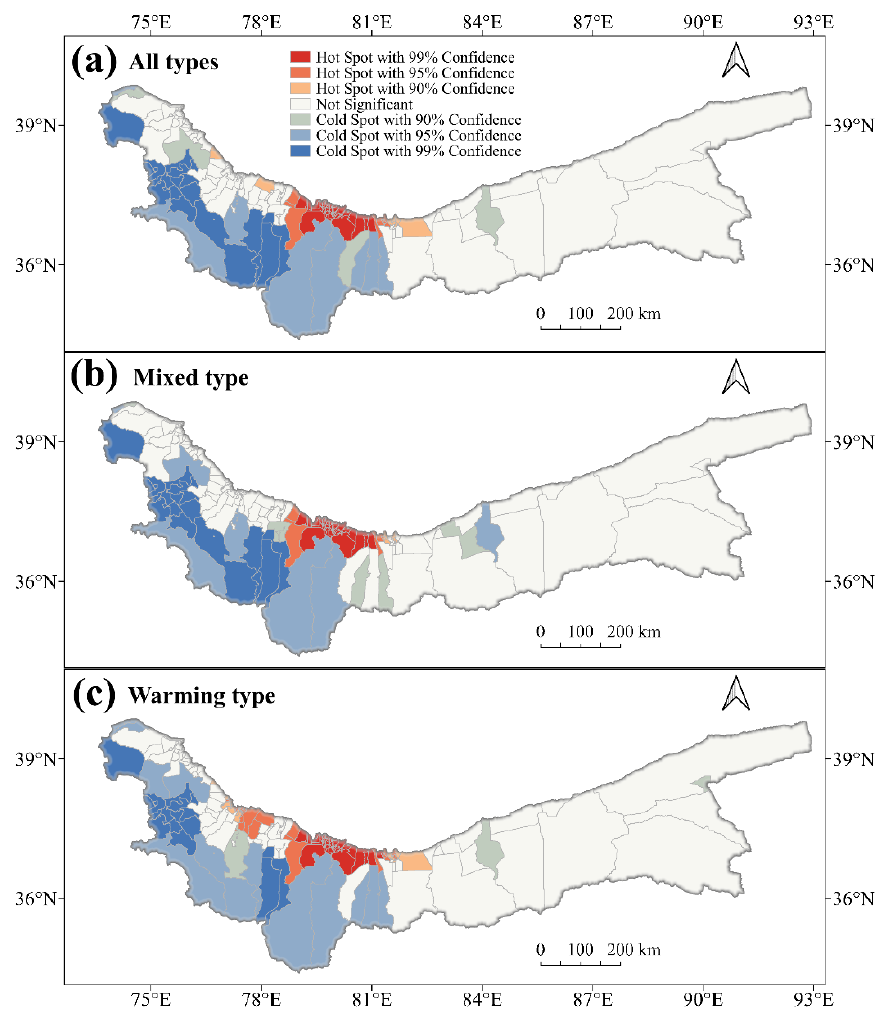
Figure 10. Hotspot analysis results.